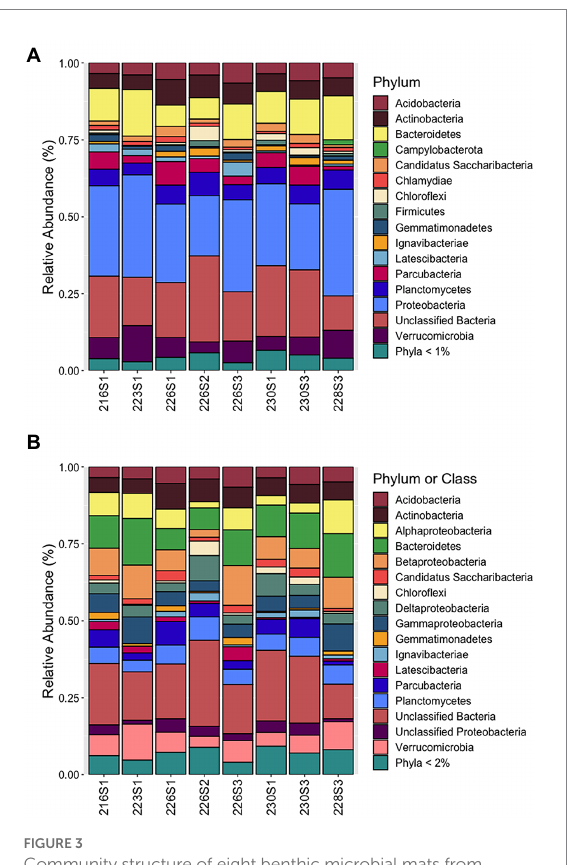
FIGURE 3 Community structure of eight benthic microbial mats from hydrothermal springs in Crater Lake, Oregon, at various taxonomic levels: (A) Community structure of abundant taxa representing >1% total reads per sample in at least one sample at the phylum level. Phyla <1% included as separate taxon; (B) Community structure of abundant taxa representing >2% total reads per sample in at least one sample at the phylum level with Proteobacteria shown at the class